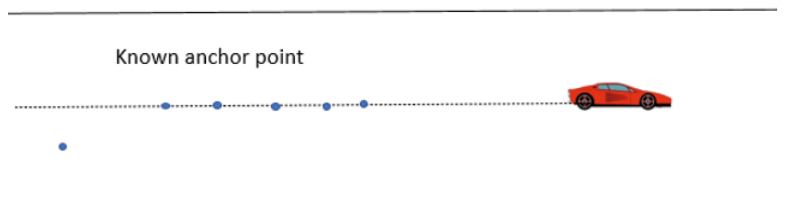
Fig. 1 . The trajectory of the vehicle is approximately a straight line.